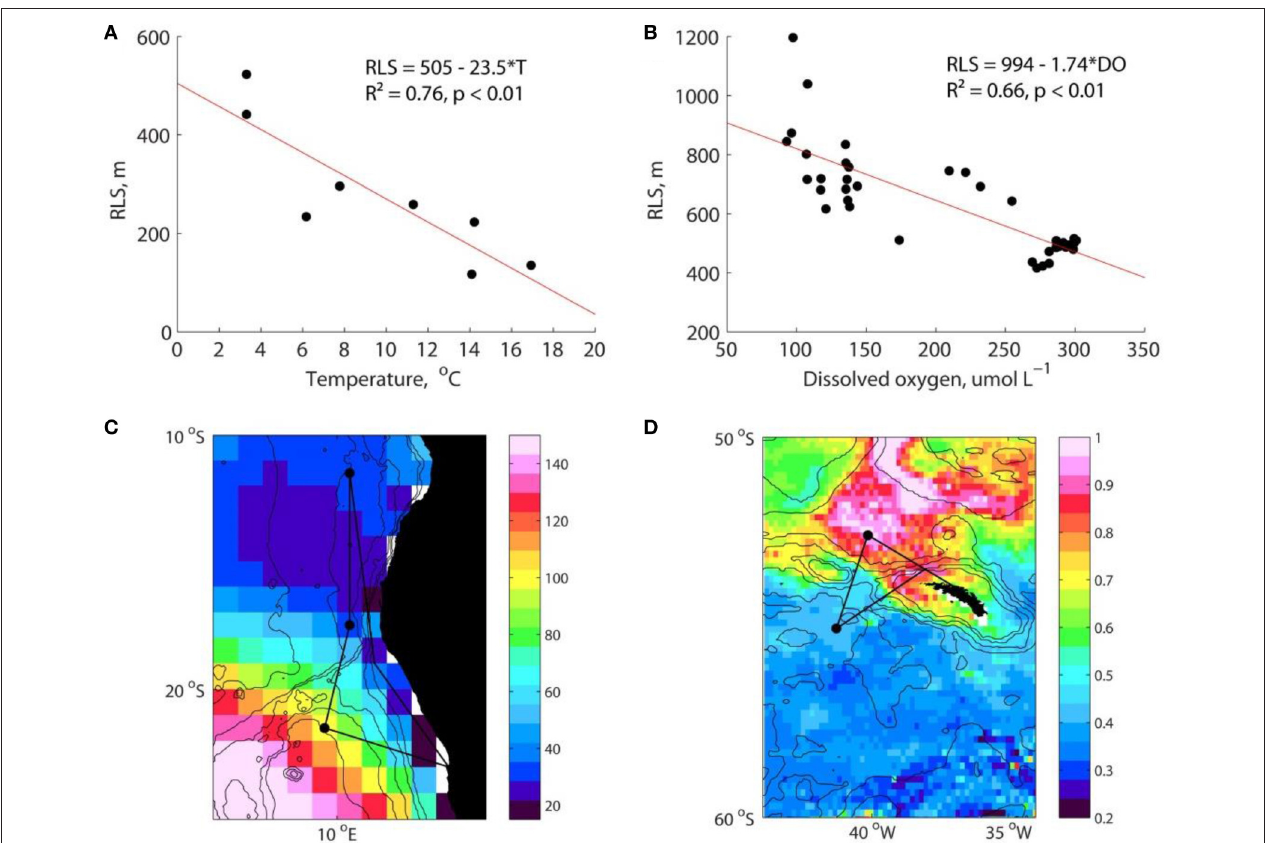
FIGURE 1 | (A) Remineralization length scale (RLS) estimated from neutrally buoyant sediment traps deployed between 60 and 600m depth plotted against 0 − 500m mean temperature. Redrawn from a data compilation presented in Marsay et al. (2015). (B) RLS estimated from thorium-derived export flux at 100m depth and moored sediment traps at 2000m depth (from data presented in Henson et al., 2012) plotted against 0 − 500m mean dissolved oxygen concentration. For both (A,B) environmental data are from the World Ocean Atlas 2013 (Locarnini et al., 2013; Garcia et al., 2014). Results from Ordinary Least Squares regression are shown. (C) Climatological minimum dissolved oxygen concentration ( µ mol L − 1 ) in July in Benguela upwelling region (Garcia et al., 2014). (D) Climatological satellite-derived primary production (gC m − 2 ) in December in the South Georgia region (estimated from MODIS data using the algorithm of Behrenfeld and Falkowski, 1997). In panels (C,D) black dots and lines show potential cruise track and major process